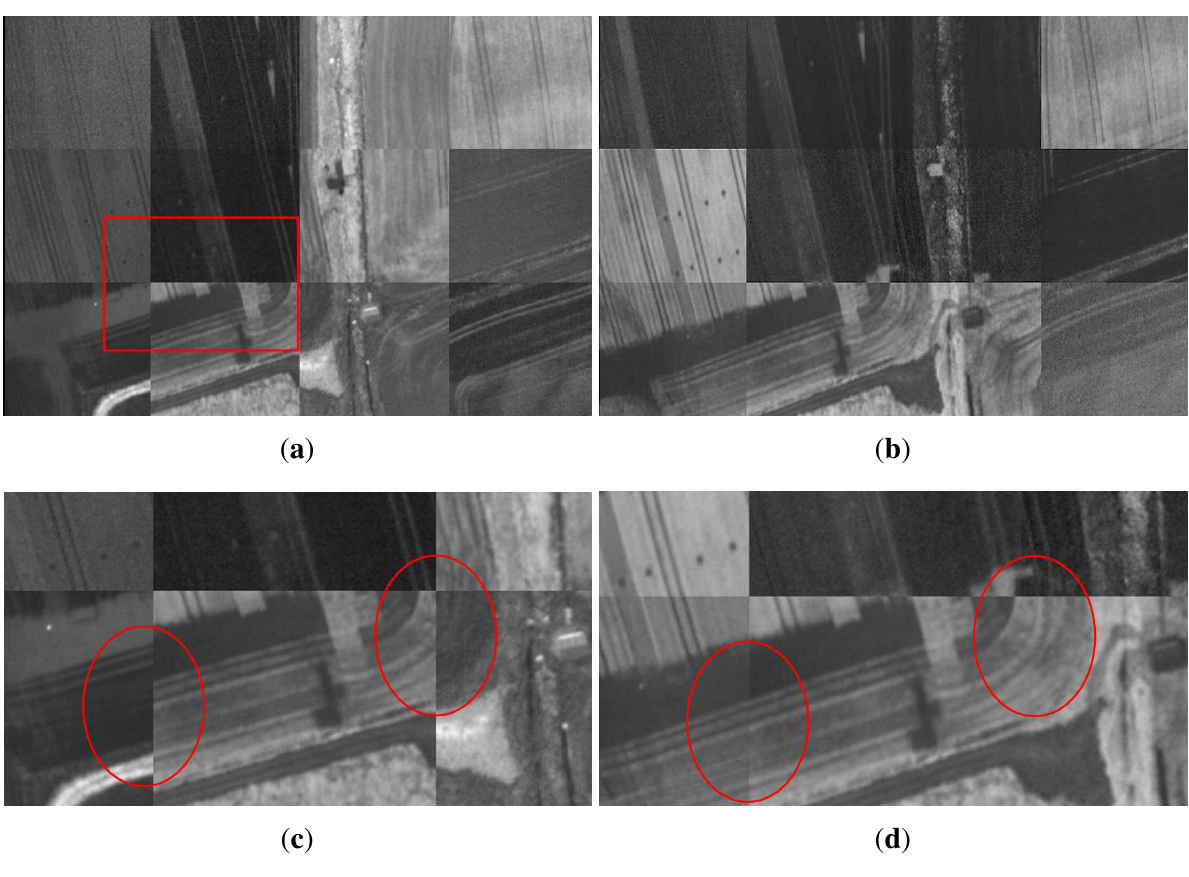
Figure 6. Registration results after the application of the developed methodology. The quantitative evaluation (Table 1) calculated an overall accuracy of approximately 1.25 pixels (dataset # 2). ( a ) Raw Unregistered Data; ( b ) Registered Data; ( c ) Zoom at Raw Data; ( d ) Zoom at Registered